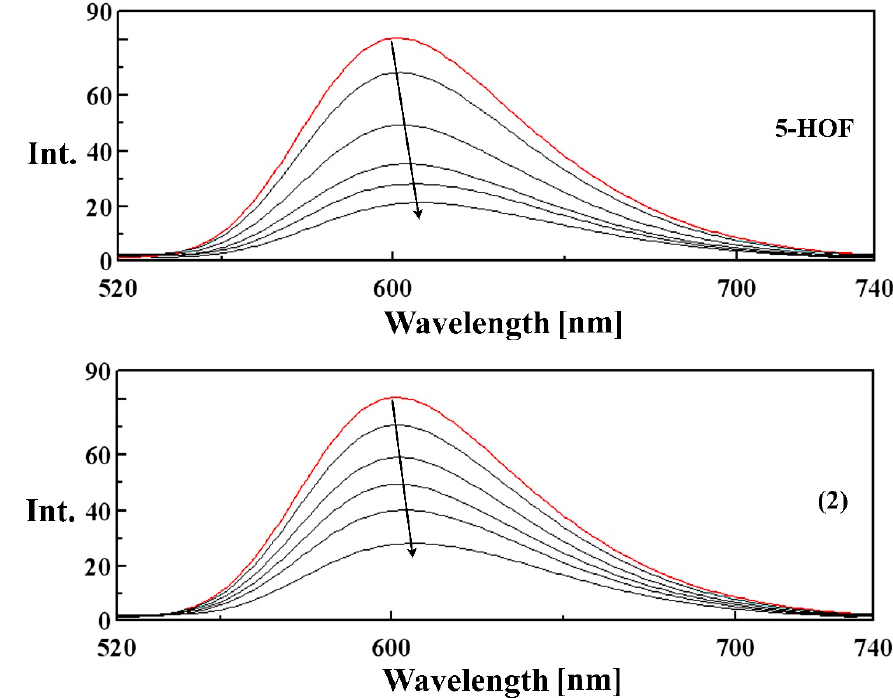
Figure 8. Fluorescence spectra of the binding of ethidium bromide (EB) to DNA in the absence (red line) and in the presence (black lines) of increasing amounts of the ligand and complex ( 2 ) λ ex = 500 nm, [EB] = 2 µM, [DNA] = 10 µM, [compound] = 10, 15, 20, 25, 30 µM. Arrows indicate the changes in fluorescence intensities upon increasing the amounts of the tested compound.